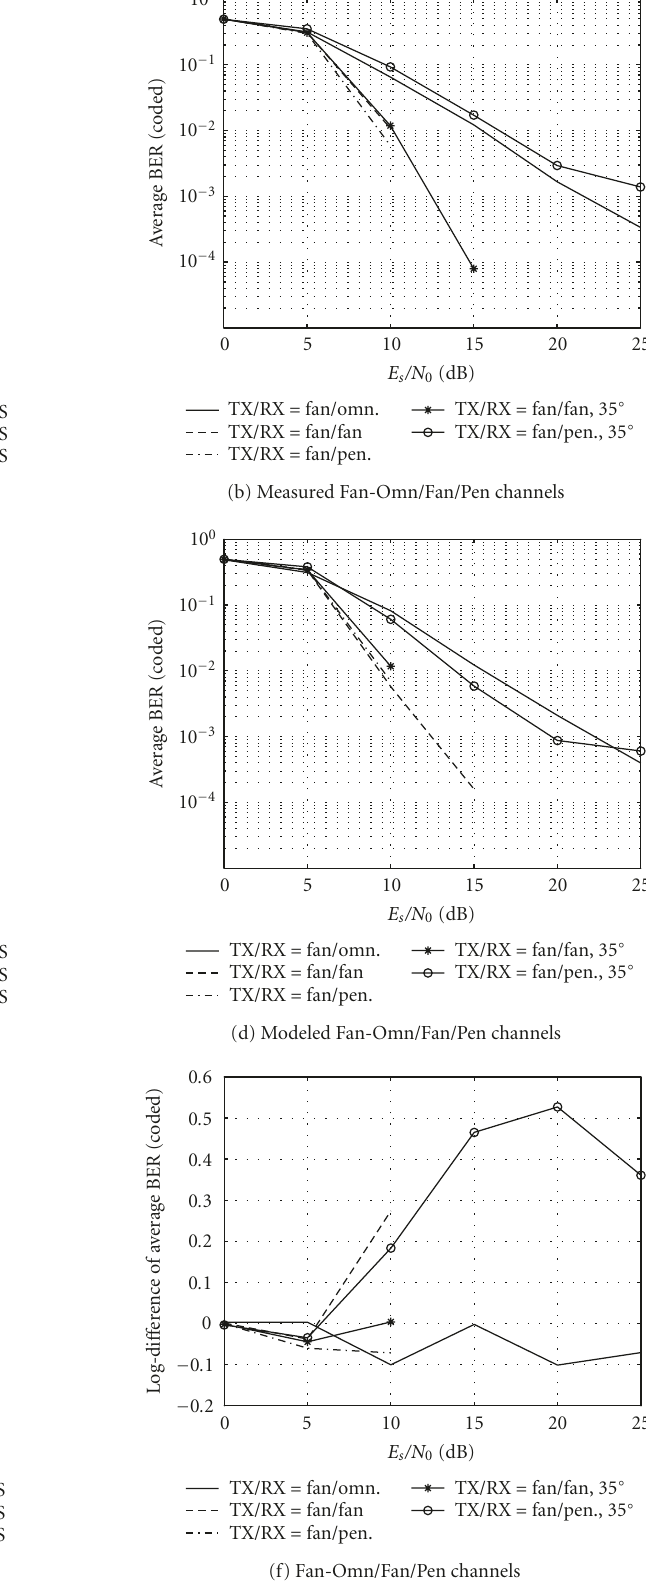
Figure 9: BER performance of coded OFDM system based on the measured and modeled channels and the log-di ff erence of average BER between